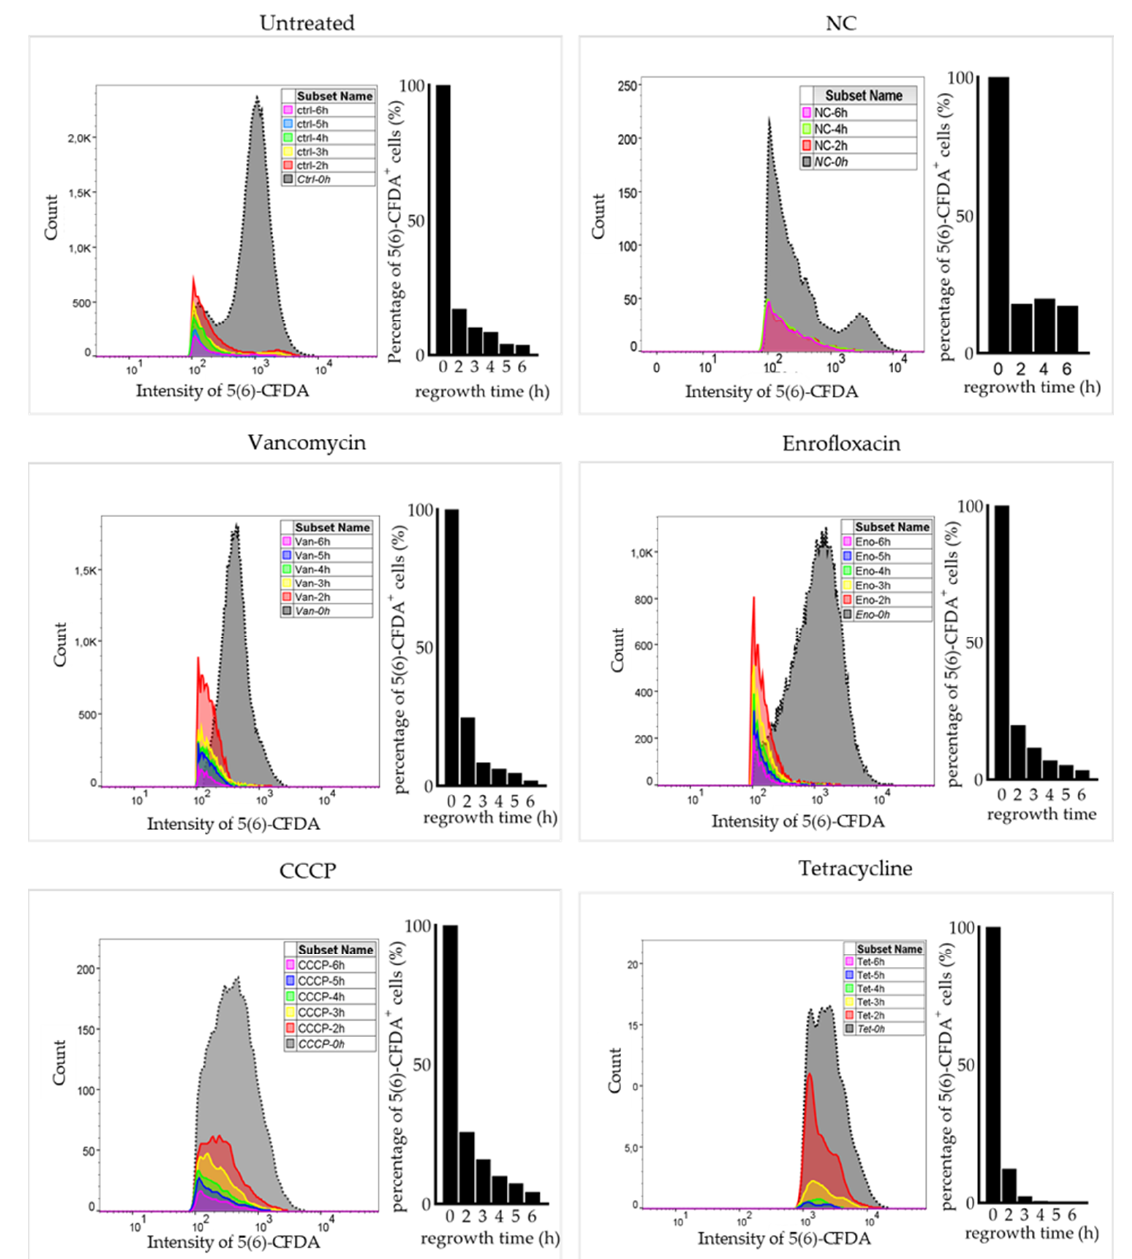
Figure 3. Surviving non-spore cells after antimicrobial treatments are persisters. Surviving non-spore cells after vancomycin, enrofloxacin, CCCP or tetracycline exposure were double stained with 5(6)-CFDA and PI. The fluorescence intensity of 5(6)-CFDA in each sample was then measured with flow cytometry, the result of which is shown as 0 h. Following this, stained cells were 1:20 diluted into LB medium and the fluorescence intensity of 5(6)-CFDA was measured after a 2-, 3-, 4-, 5-, and 6 h incubation. The intensity of 5(6)-CFDA in single cells ( left ) and the percentage of 5(6)-CFDA positive cells compared with the 0 h sample ( right ) are shown for each sample. Results showed that 5(6)-CFDA intensity and the number of 5(6)-CFDA positive non-spore cells gradually decreased during a 6 h incubation in LB medium after stress removal. Compared with the relatively sTable 5(6)-CFDA signal in the negative control (NC) of untreated cells 1:20 inoculated into 0.85% NaCl, the decrease was caused by the regrowth of non-spore cells after stress removal. Note that 0 h was sampled before inoculation and contained more cells than the samples of other time points.